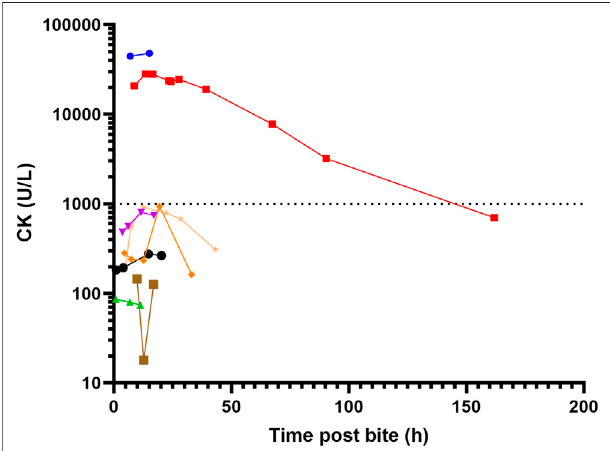
FIGURE 4 | Serial creatine kinase (CK) measurement for eight patients with sea snake envenoming, two with myotoxicity (peak CK > 1000